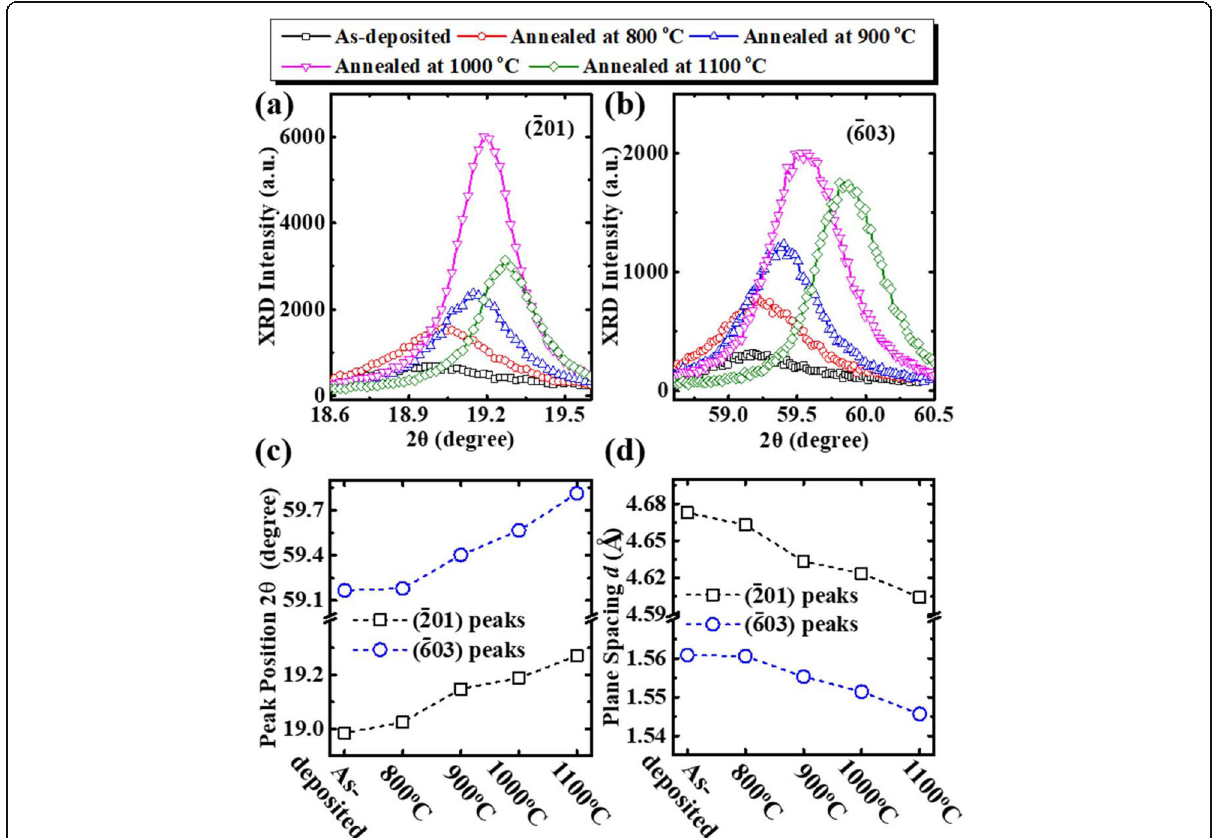
Fig. 3 The XRD peaks of a ð 201 Þ plane and b ð 603 Þ plane of the samples before and after annealing. c peak position and d plane spacing of ð 20 1 Þ and ð 603 Þ planes